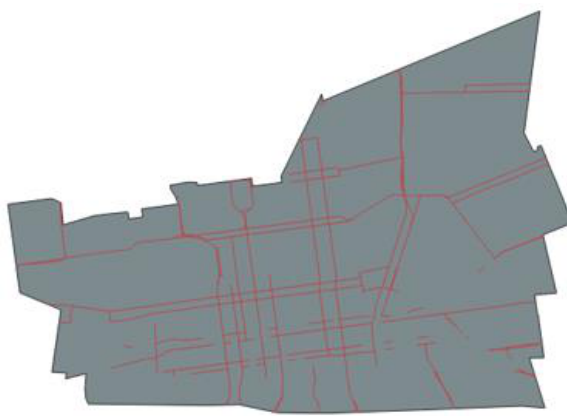
Figure 3 . Clipped and filtered road feature class.